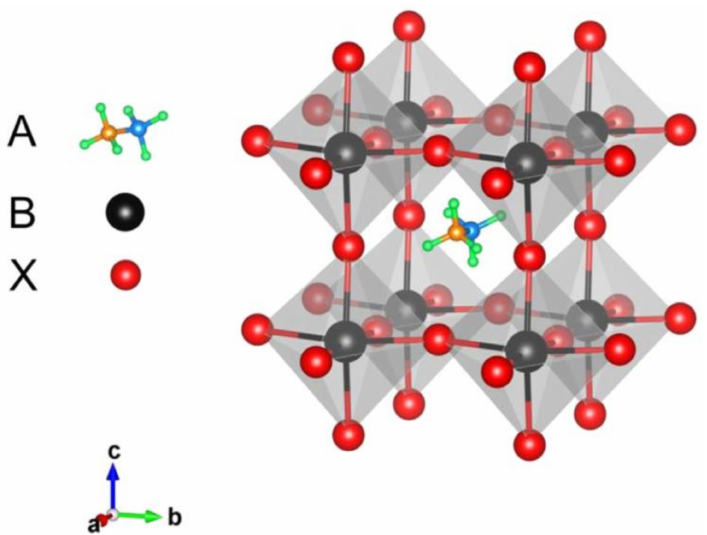
Figure 1. Crystal structure of an organic–inorganic metal halide perovskite. Reproduced with permission from Reference